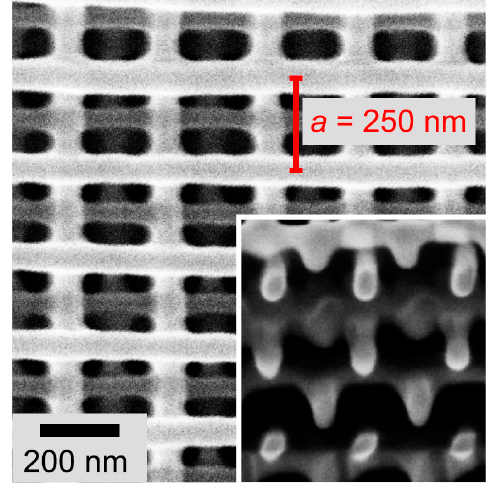
Figure 8. SEM image of a woodpile structure fabricated by TPL with a laser of wavelength 405 nm. Smallest line width is reported to be 68 nm. Reprinted with permission from ref [83] © The Optical Society.